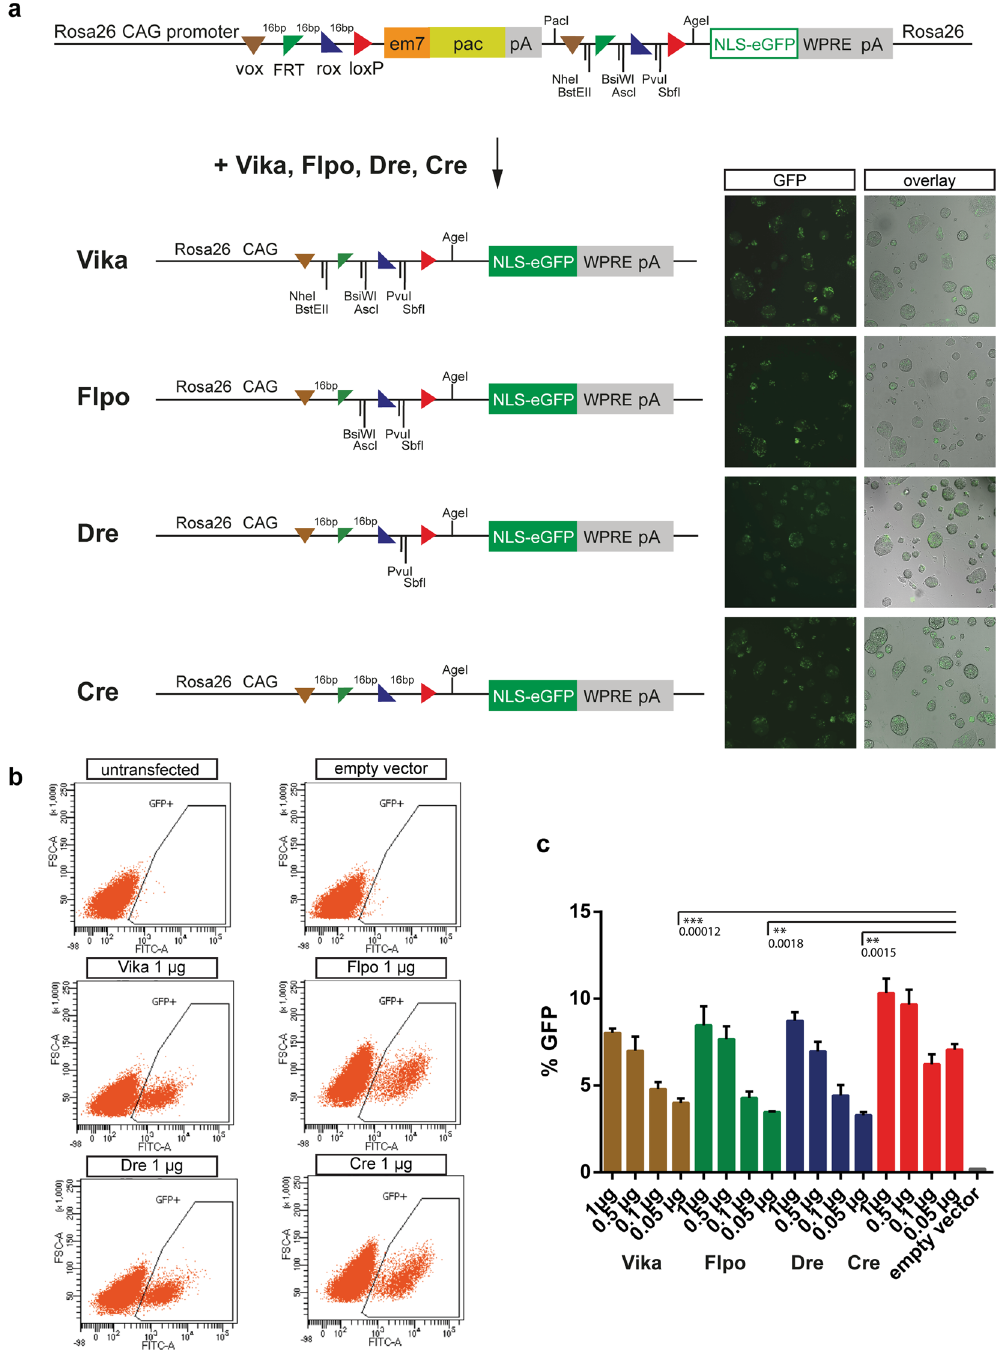
Figure 2. The multi site reporter vector is functional in mESCs. ( a ) Schematic diagram of the Rosa26-multi site reporter (MuX) before and after Vika, Flpo, Dre and Cre recombination. Stable mESC reporter clones were transiently transfected with expression vectors and analysed at 48 h for GFP expression. ( b ) Flow cytometry to measure GFP levels after transfecting different amounts of the recombinase expression vectors (0.05 to 1 µ g per 6-well). Representative plots of cells transfected with 1 µ g recombinase expression vector are shown. ( c ) Quantification of ( b ). Error bars represent standard deviations. Statistical significance is shown only for P < 0.01 ( ** ) and P < 0.001 ( ***